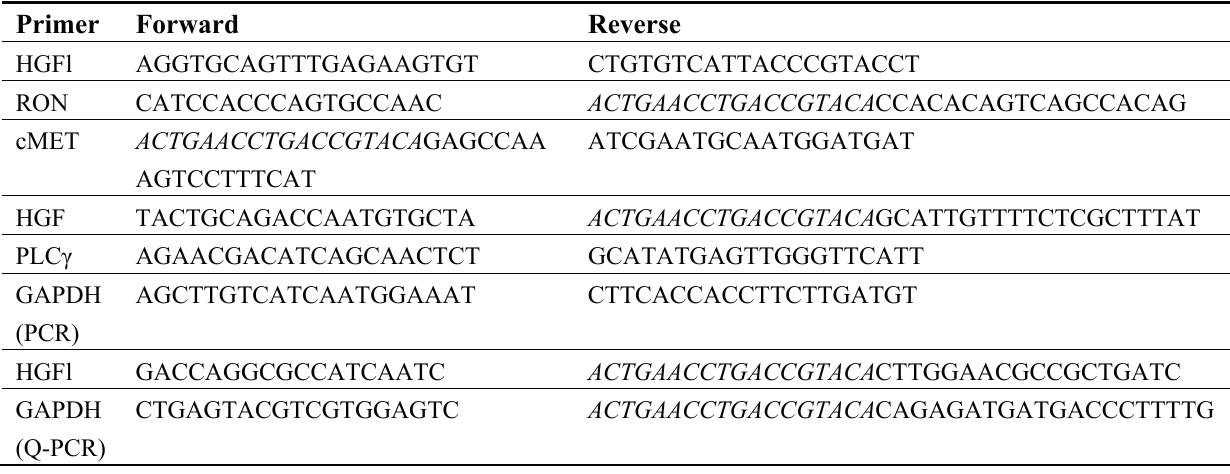
Table 1. Primers used for polymerase chain reaction (PCR) and quantitative polymerase chain reaction (Q-PCR) ( ACTGAACCTGACCGTACA is the z